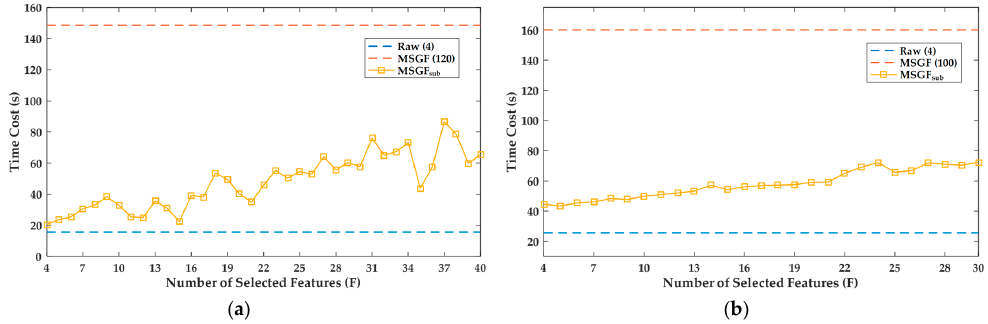
Figure 12. Comparison of the time efficiency with feature selection and without feature selection: ( a ) results on Zh1 and ( b ) results on Zh2.